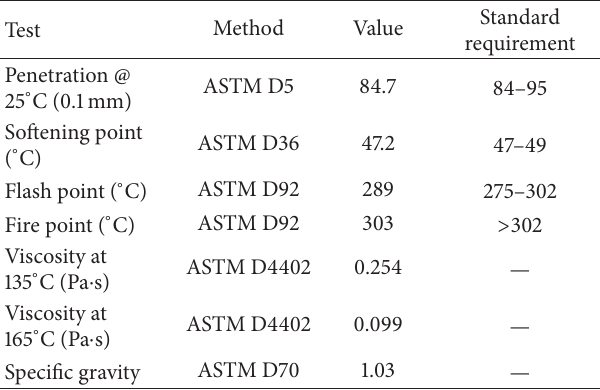
Table 3: 80/100 binder test